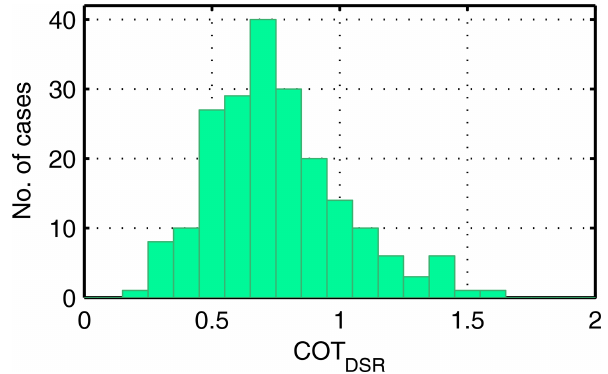
Figure 3. Distribution of COT retrieved from DSR (COT DSR ) for stratus–altostratus cases in Payerne. The geometric mean COT DSR value is 33.8 with a geometric standard deviation of 1.7.